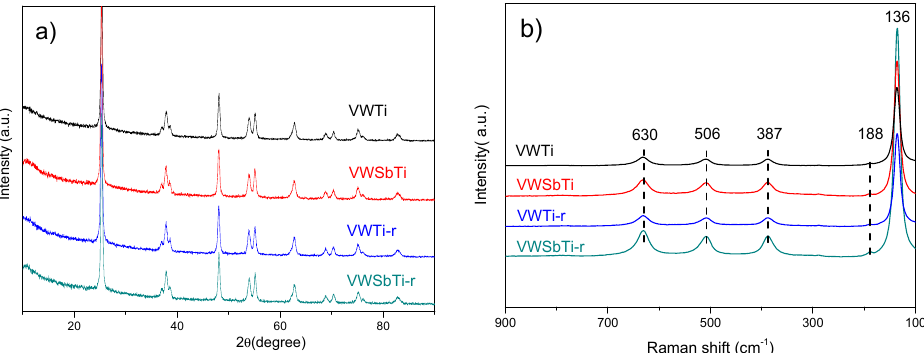
Figure 4. ( a ) XRD diffraction patterns and ( b ) Raman spectra for different samples.